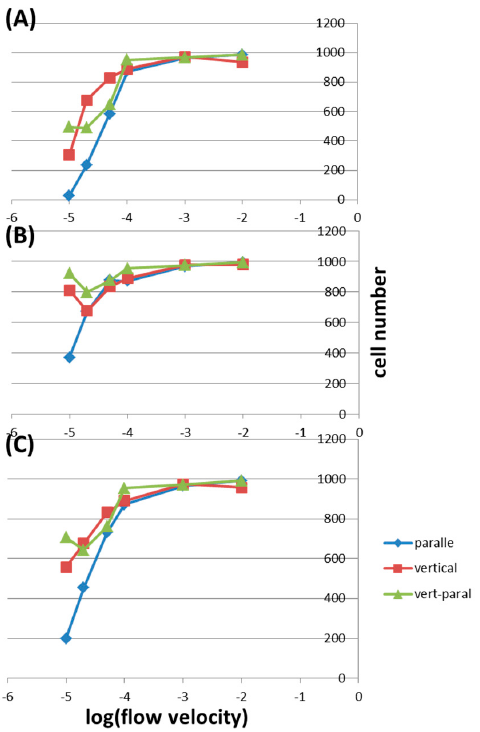
Figure 5. The cell numbers counted in the outlet under different inlets and flow velocities by using ( A ) the Freeze wall condition and ( B ) the Diffuse scattering wall condition; ( C ) The average cell numbers of ( A , B ).